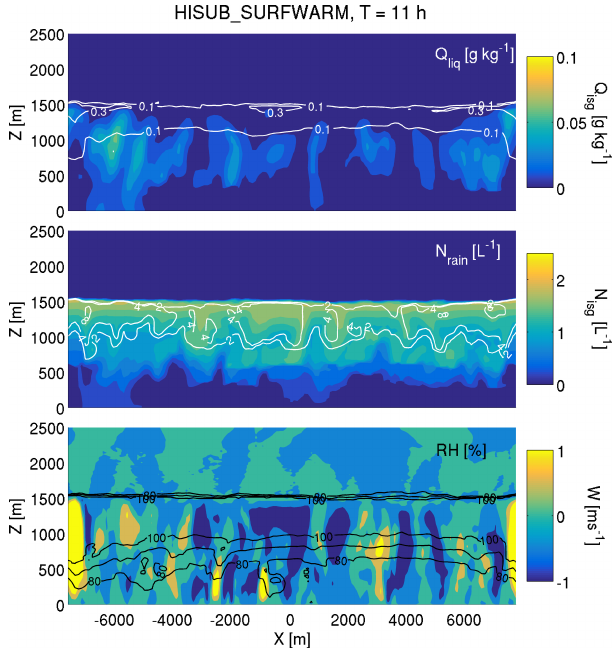
Figure 11. Z – X slices for the CNTRL_SURFWARM case at 10h. (a) Total ice mass mixing ratio ( Q isg , shading) and liquid water mass mixing ratio ( Q liq , contours). (b) Total ice number concen- tration (ice + snow + graupel, N isg , shading) and rain number con- centration ( N rain , contours). (c) Vertical velocity ( W , shading) and relative humidity (RH, contours). Identified detached below-cloud cumuli are highlighted by red ellipses, and cumuli merged with the Sc are indicated by white ellipses.